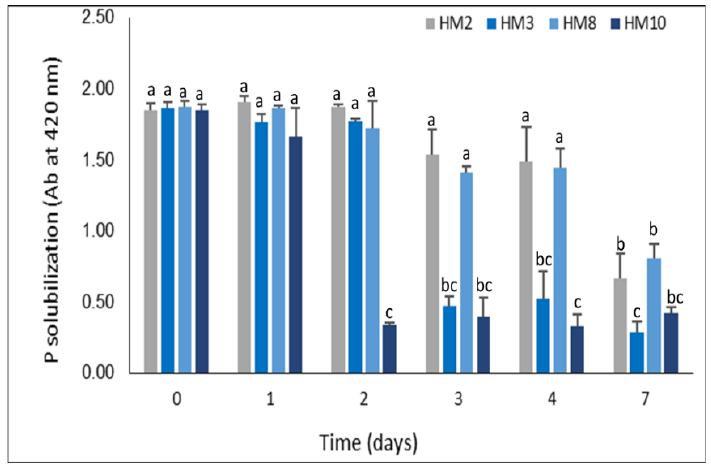
Figure 4. Phosphate solubilization of inorganic phosphate by the selected four Streptomyces strains grown in NBRIP-liquid medium supplemented with 5 g/L of Ca 3 (PO 4 ) 2 for 7 days, each value represents the mean of three replicates. Bars not sharing similar letters are significantly different ( p > 0.05). When subjected to the extracted and purified S. tricolor HM10 broth into HPLC, a reliable peak with a retention time of 12.019 min was detected in the bacterial broth. The